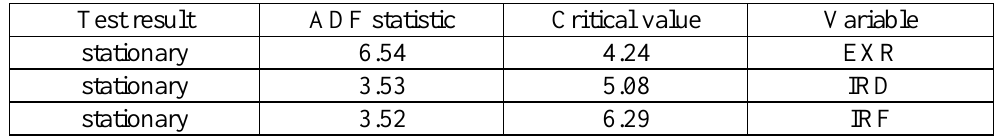
Table 2. Results from ADF with a first-order difference